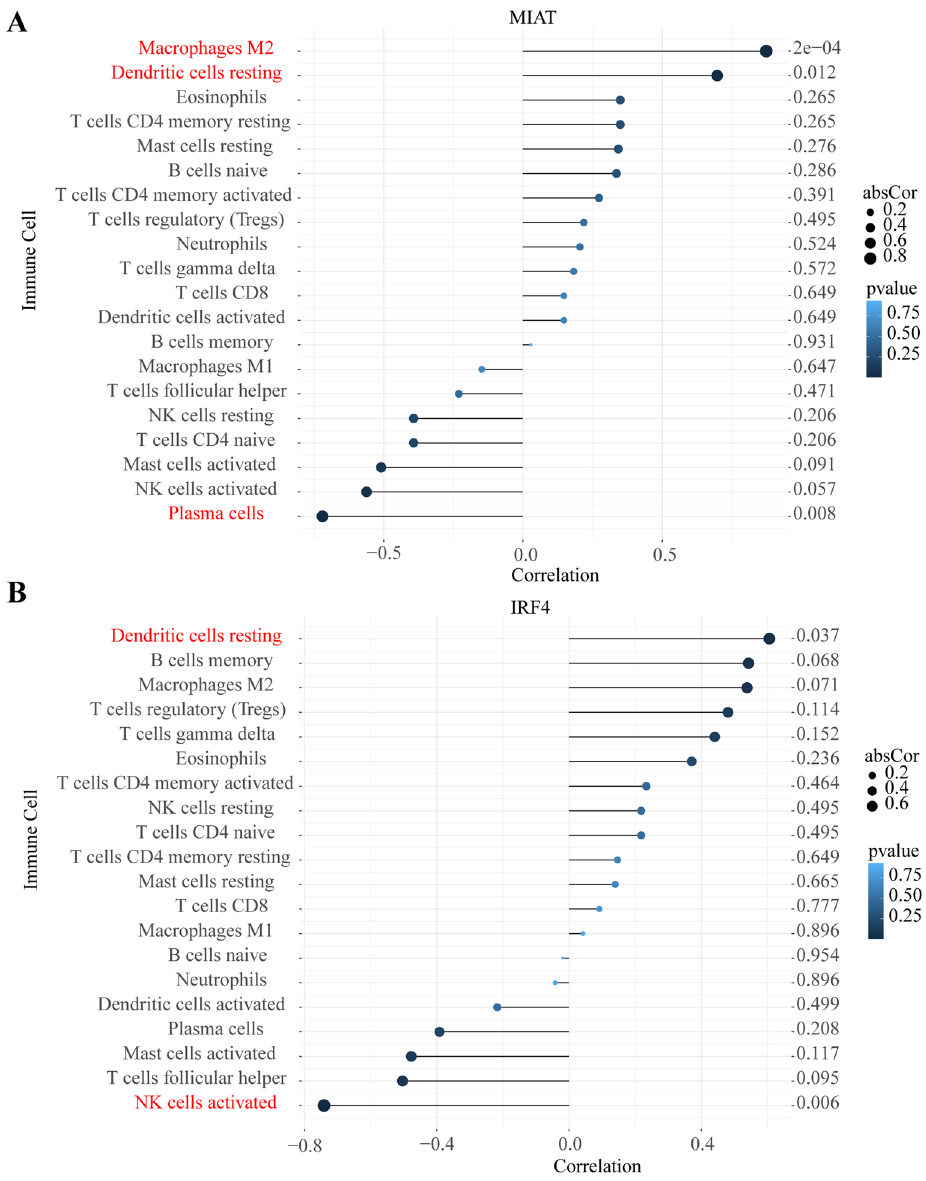
Figure 7. Correlation between the ceRNA axis (MIAT and IRF4) and infiltrating immune cells. ( A ) Correlation between MIAT and infiltrating immune cells. ( B ) Correlation between IRF4 and infiltrating immune